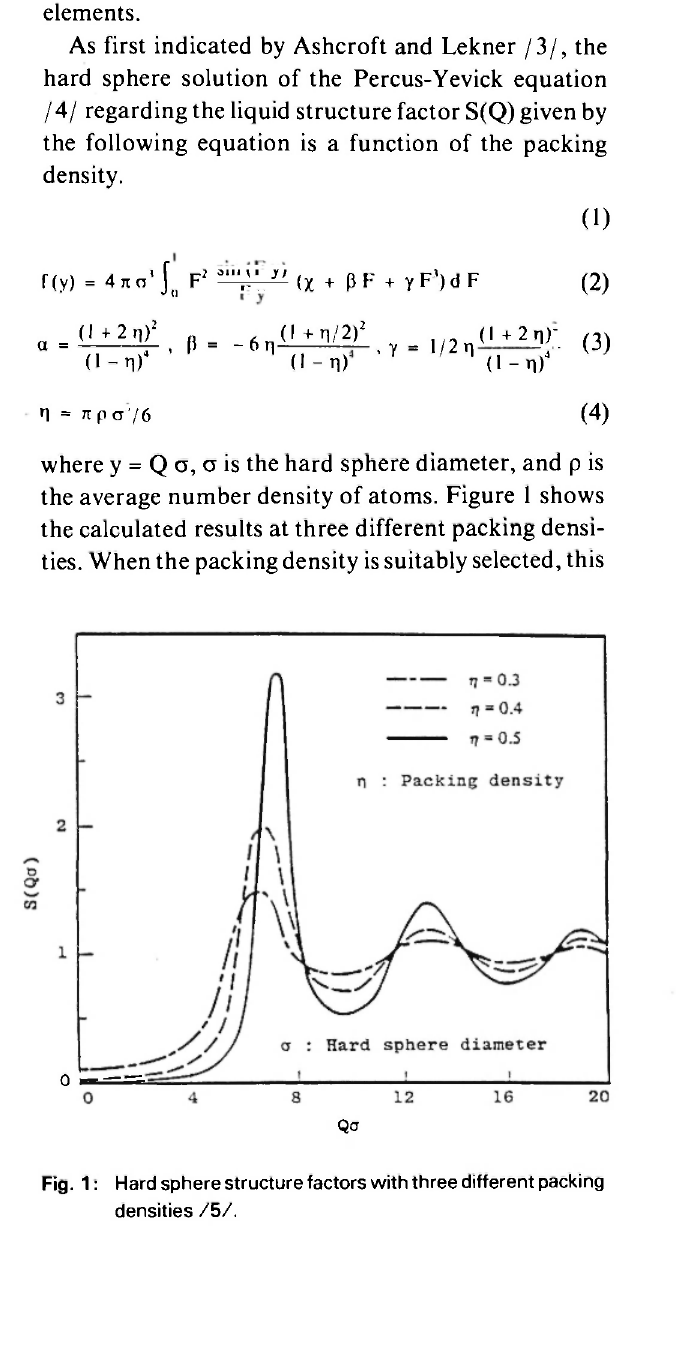
Fig. 1: Hard sphere structure factors with three different packing densities